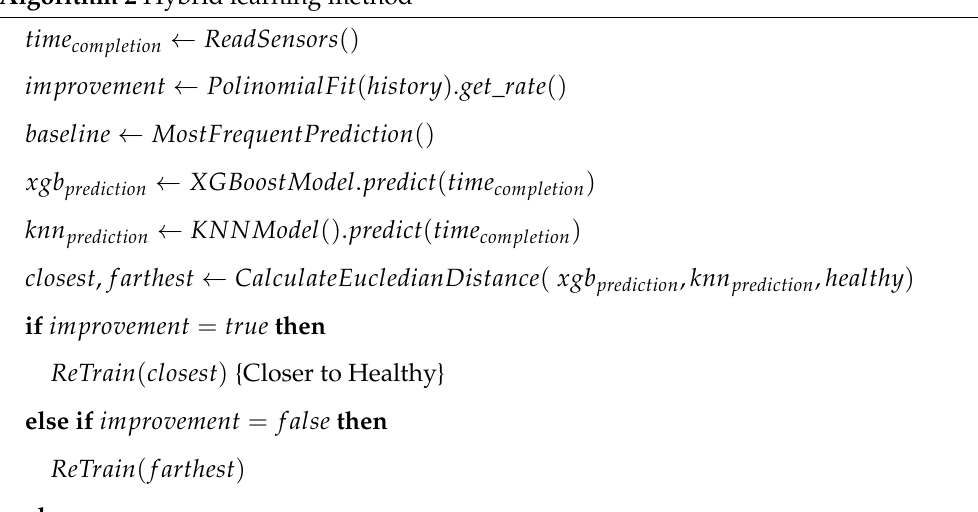
Algorithm 2 Hybrid learning